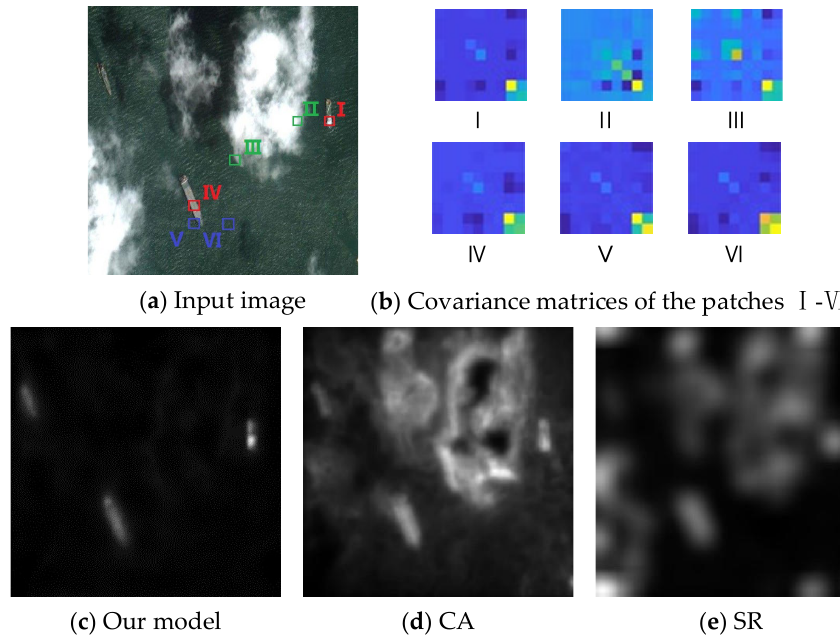
Figure 2. Saliency model based on regional covariance analysis. ( a ) The input remote sensing image. ( b ) Covariance matrixes of different patches. By using our context similarity measurement, the smaller the similarity distance (SD) is, the more similar the selected patches are. The SDs among different patches are d (I,II) = 12.98, d (I,III) = 13.30, d (I,IV) = 3.70, d (I,V) = 14.41, d (I,VI) = 8.60. ( c – e ) Subjective comparison of CA, SR, and the proposal model.